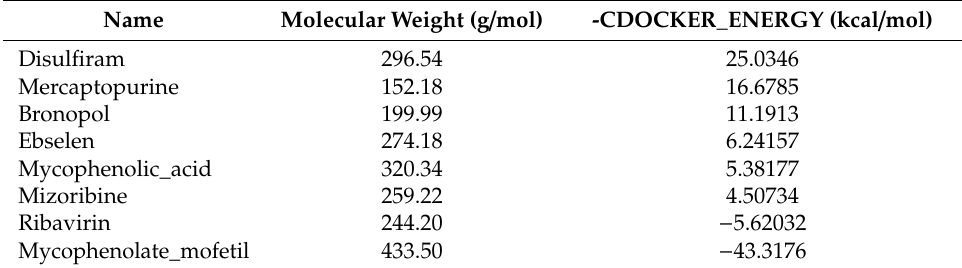
Table 2. Detailed summary of the docking binding a ffi nities (kcal /